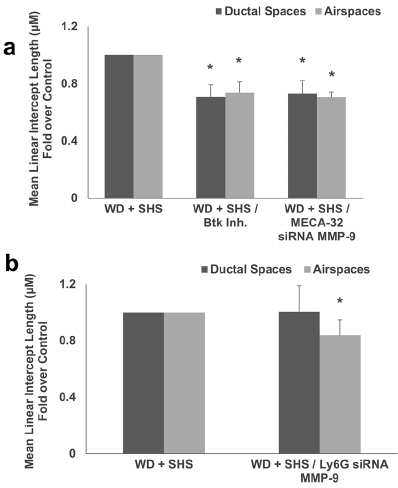
Figure 6. ( a ) Morphometric analysis of lungs from ApoE − / − mice fed WD and exposed to SHS only (WD + SHS), with Btk inhibitor treatment (WD + SHS/Btk Inh.), or treated with endothelial cell targeted siRNA for MMP-9 (WD + SHS/MECA-32 siRNA MMP-9) showed reduced scores in treatment groups ( p < 0.05). Kruskal-Wallis ANOVA on ranks was used to assess statistical significance between groups ( p < 0.001) followed by post hoc testing with Dunn’s multiple comparison test for groups of interest, four to six animals per group were evaluated, with two groups of control animals combined. ( b ) Analysis of MLI in lungs of ApoE − / − mice fed WD and exposed to SHS or fed WD and exposed to SHS plus treatment with neutrophil targeted siRNA for MMP-9 (WD + SHS/Ly6G siRNA MMP-9) showed reduced scores in the treatment group ( p > 0.001). Student’s t -test was used to assess statistical significance, four mice per group were analyzed. * Significant difference detected.